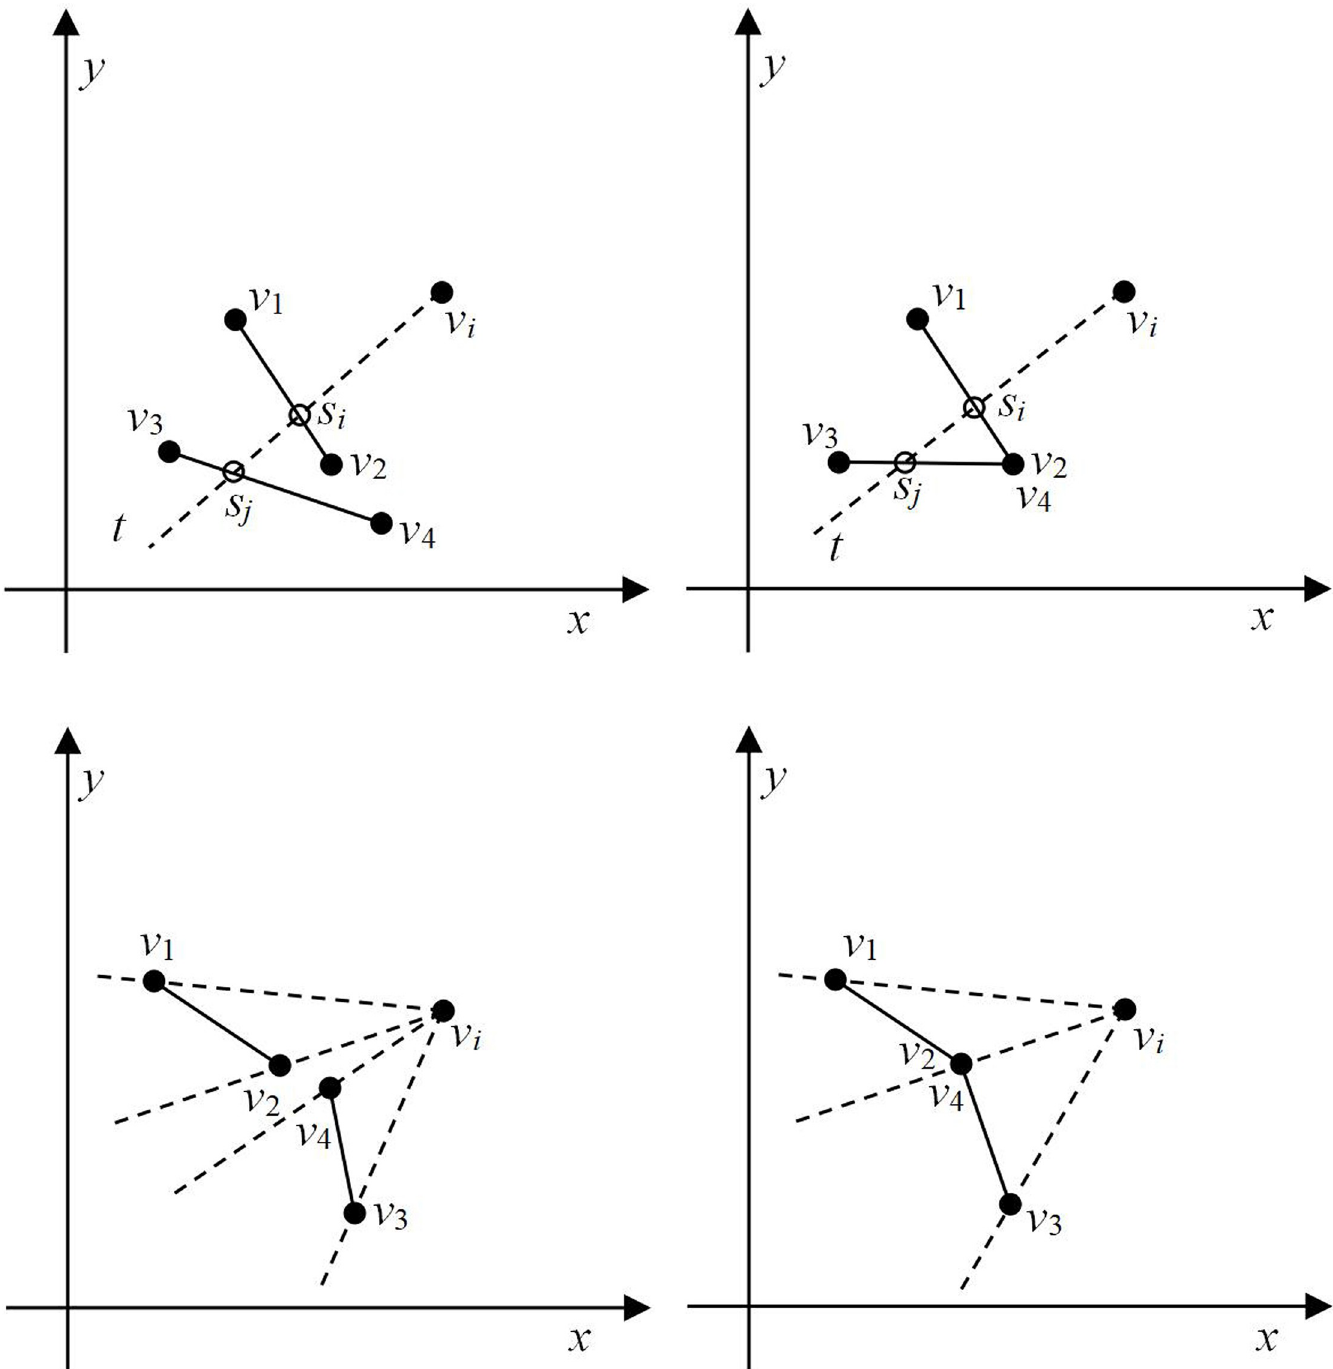
Fig 3. Examples of occlusion. (a) Occlusion with no intersection, (b) occlusion with intersection, (c) no intersection & no occlusion, and (d) no occlusion with intersection.